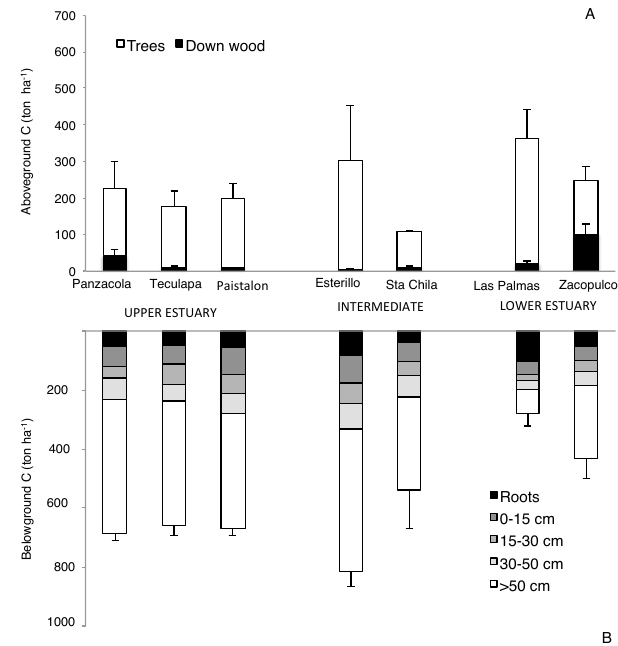
Figure 3. Aboveground (a) (trees and shrubs and down wood) and belowground (b) (soil at different depths and roots) carbon stocks (MgCha − 1 ) of mangroves along a gradient from the upper to the lower estuary within La Encrucijada Biosphere